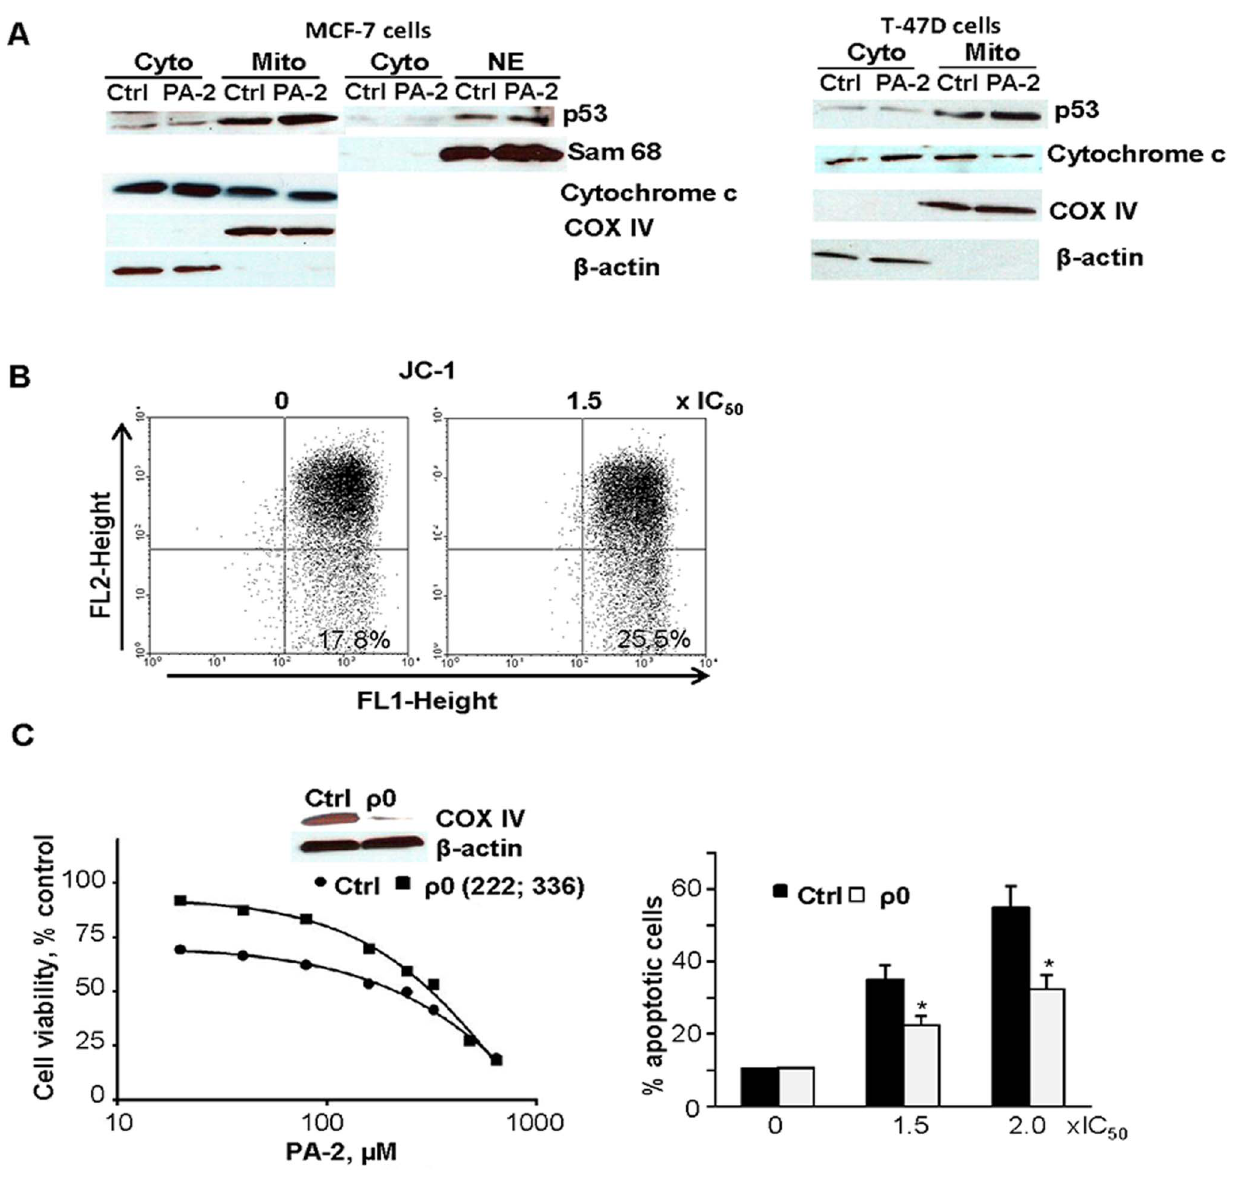
Figure 5. Phospho-aspirin-2 induces mitochondrial translocation of p53 and mitochondria-dependent apoptosis. A: The mitochondrial, cytosolic and nuclear levels of p53 and cytochrome c were determined after treatment with PA-2 by western blot. B: PA-2 caused the collapse of mitochondrial membrane potential ( Dy m ), as indicated by the increased JC-1 fluorescence relative to the control. C: Mitochondria- depleted MCF7 cells ( r 0 ) showed resistance to PA-2. Left : Immunoblotting of control and r 0 MCF7 cell lysates for the specific marker mitochondrial protein COXIV (top) and the effect of PA-2 on the viability of parental and r 0 MCF7 cells was determined by the MTT assay (bottom). Right : r 0 MCF7 cells were resistant to PA-2-induced apoptotic cell death, as measured by Annexin V/PI staining and flow cytometry (results are the average of three independent experiments, *p , 0.05).